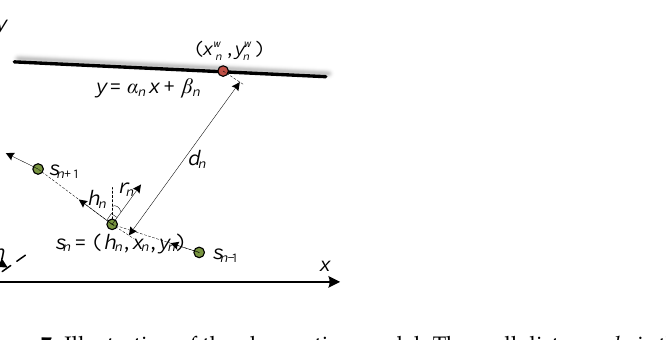
Figure 7. Illustration of the observation model. The wall distance d n is the straight-line distance from the observation point s n = ( h n , x n , y n ) to the wall point ( x w n , y w n ) along ranging direction r n